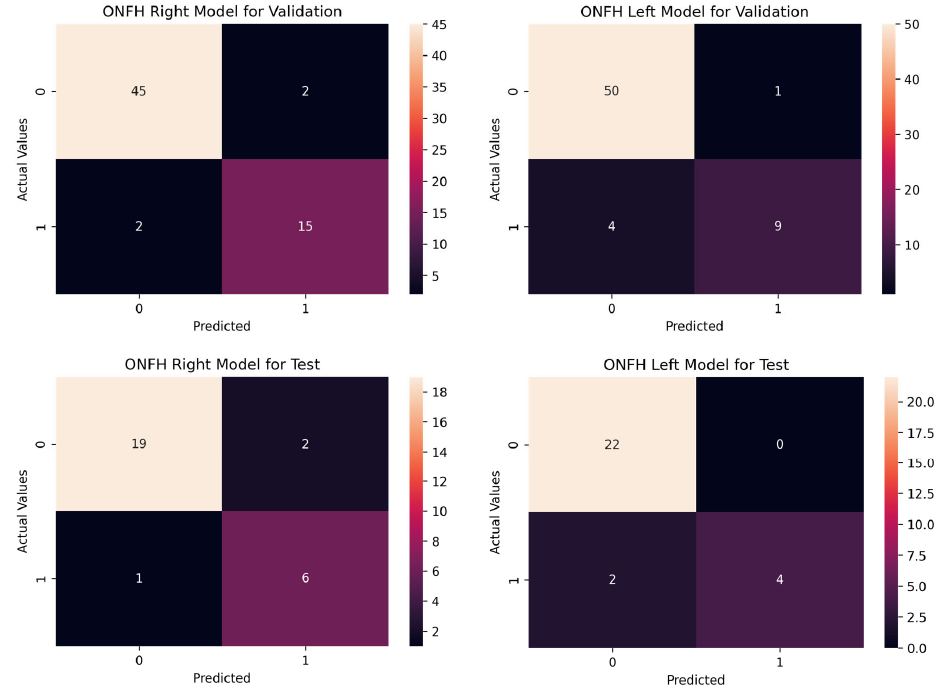
Figure 5. Confusion matrix for osteonecrosis of the femoral head (ONFH) right and left models.